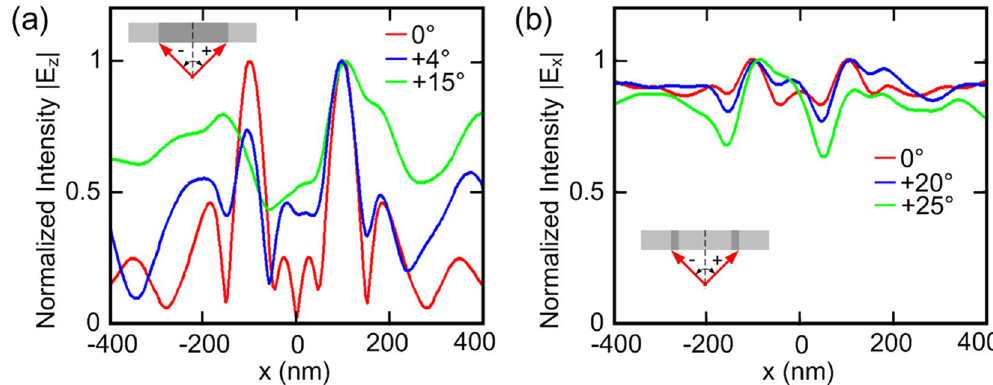
Figure 5. Characterization of the HPEDL for oblique incident light. ( a ) The HPEDL is utilized to detect the PMMA strip with 200 nm width that embedded in the PC substrate. ( b ) The HPEDL is utilized to detect two PMMA strips with 20 nm width and a center-to-center separation of 200 nm.